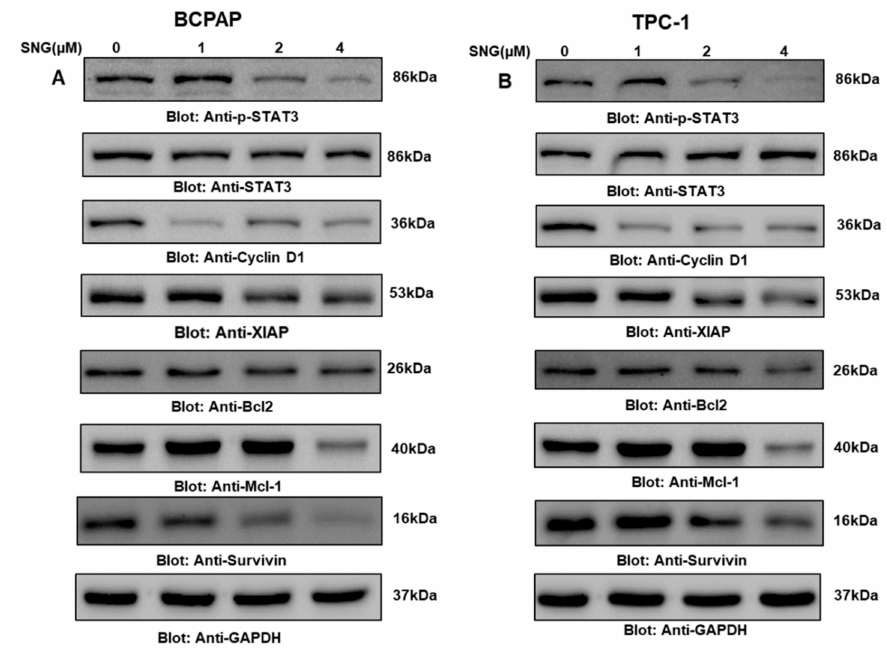
Figure 5. SNG suppresses the constitutively activated STAT3 signaling pathway. BCPAP ( A ) and TPC-1 ( B ) cells were treated with increasing doses of SNG for 4 h, as indicated. After cell lysis, equal amounts of proteins were separated by SDS–PAGE, transferred to a PVDF membrane, and immunoblotted with antibodies of p-STAT3 (Try705) , STAT3, Cyclin D1, XIAP, Bcl2, MCL1, survivin and